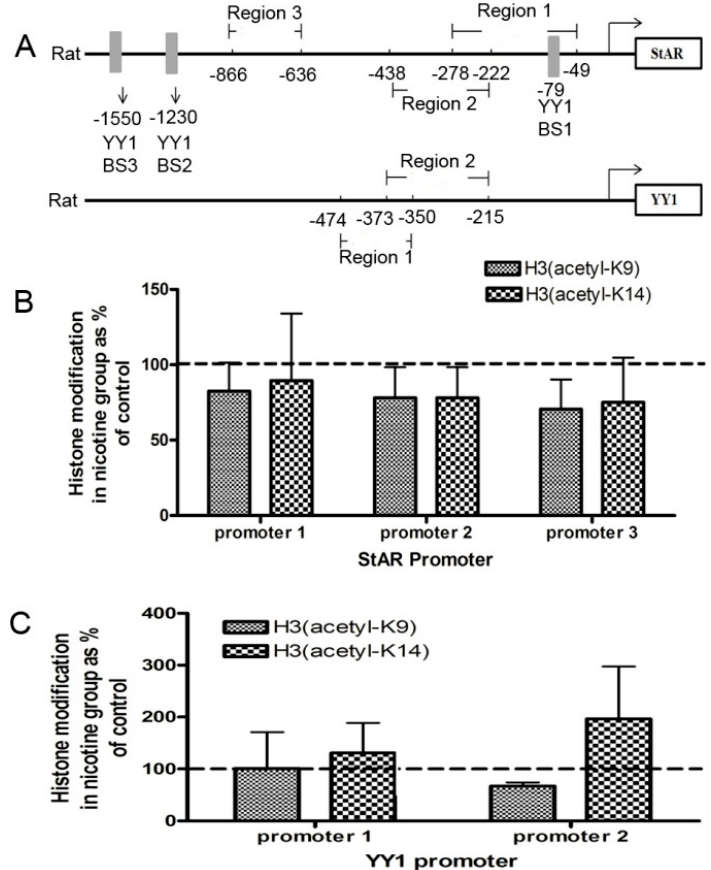
Figure 2. Effects of prenatal nicotine exposure on histone modification of the steroidogenesis acute regulatory protein (StAR) and Yin Yang 1 (YY1) promoters in fetal rat adrenal glands. ( A ) Schematic of the rat StAR and YY1 promoter structure; three potential YY1 binding regions (YY1 BS 1–3) are indicated; ( B ) chromatin immunoprecipitation (ChIP) analysis for histone acetylation levels in StAR promoters; ( C ) ChIP analysis for histone acetylation levels in YY1 promoters. After immunoprecipitating the complex with antibodies against acetyl histone H3K9, H3K14, or IgG, we detected the mRNA expression of StAR and YY1 using qRT-PCR. Data are presented as the mean ± SEM, all fetal adrenal glands of different pups from the same pregnant rats were merged into one sample, n = 3; dashed line indicated the control group was 100%.